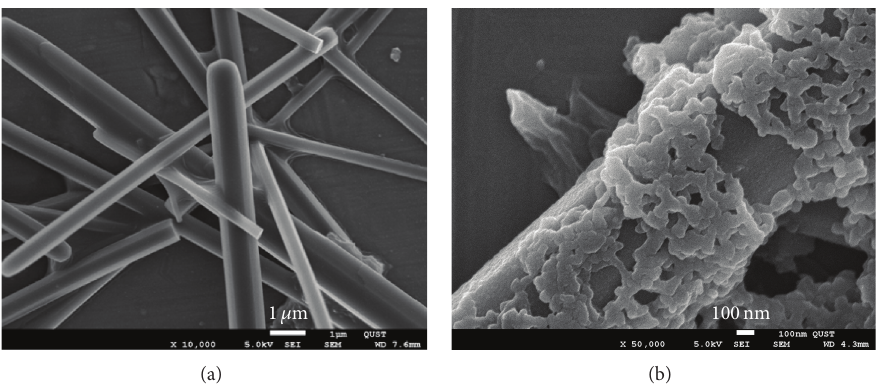
Figure 1: SEM images of (a) FWs and (b) PANI-EB-doped